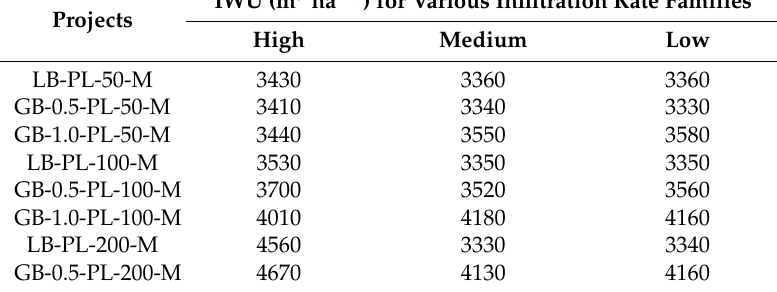
Table 10. Gross irrigation water use (IWU, m 3 ha − 1 ) during the crop season for several projects with medium inflow rates as influenced by soil infiltration—high, medium, and low (defined in Figure 3). Projects